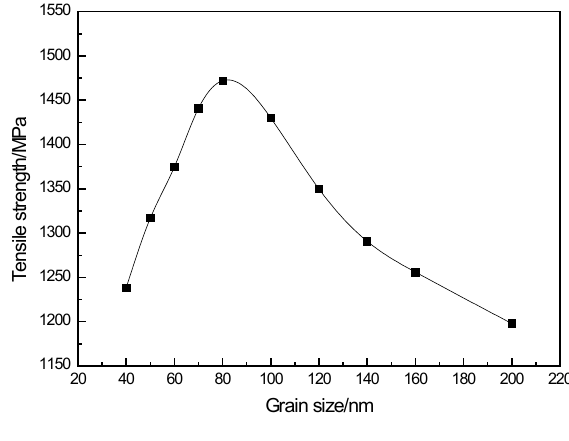
Figure 6: Influence of grain size on the tensile strength of carbon fiber reinforced nanocrystalline nickel composite electroforming